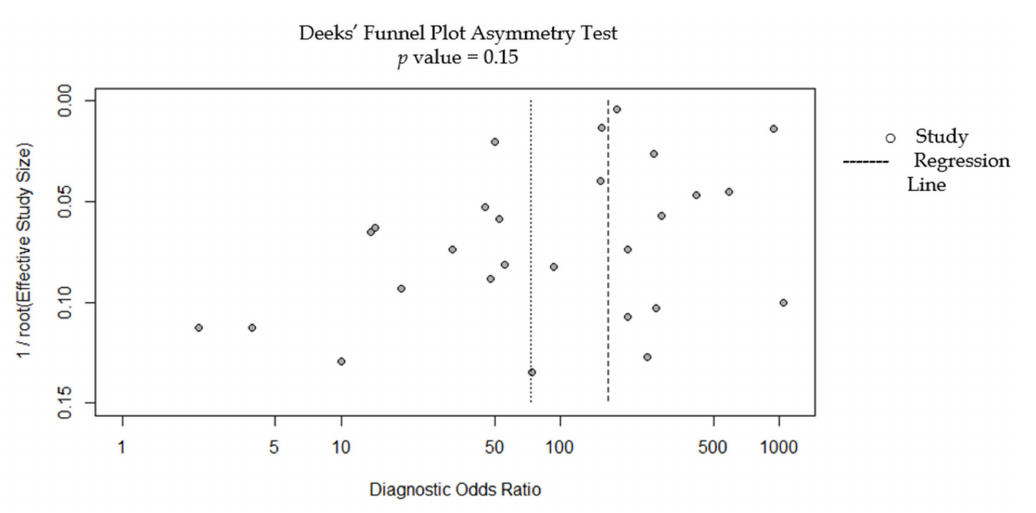
Figure 5. Deeks’ funnel plot of the performance of the DL model for the diagnosis of esophageal